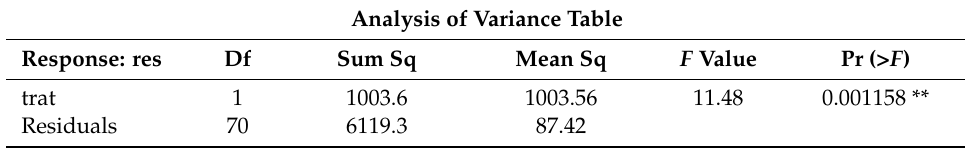
Table A15. R output of Anova among the residues generated from the estimation of AGFM using species equation and age specific equation for C